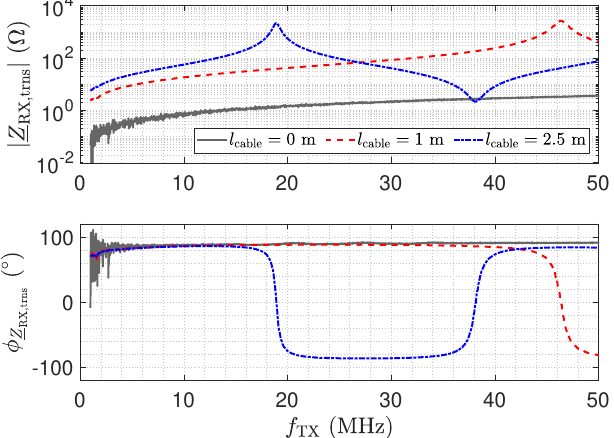
(cid:12) (cid:12) Figure 11. Measured magnitude of the transformed input impedance (cid:12) Z RX,trns (cid:12) and phase φ Z RX,trns according for the low-Z receiver depicted in Figure 10, for three different transmission line lengths. The result for a length of 0m corresponds to Z RX . At the point where the blue trend and the gray (cid:12) (cid:12) trend of (cid:12) Z RX,trns (cid:12) meet, a λ /2 setup is